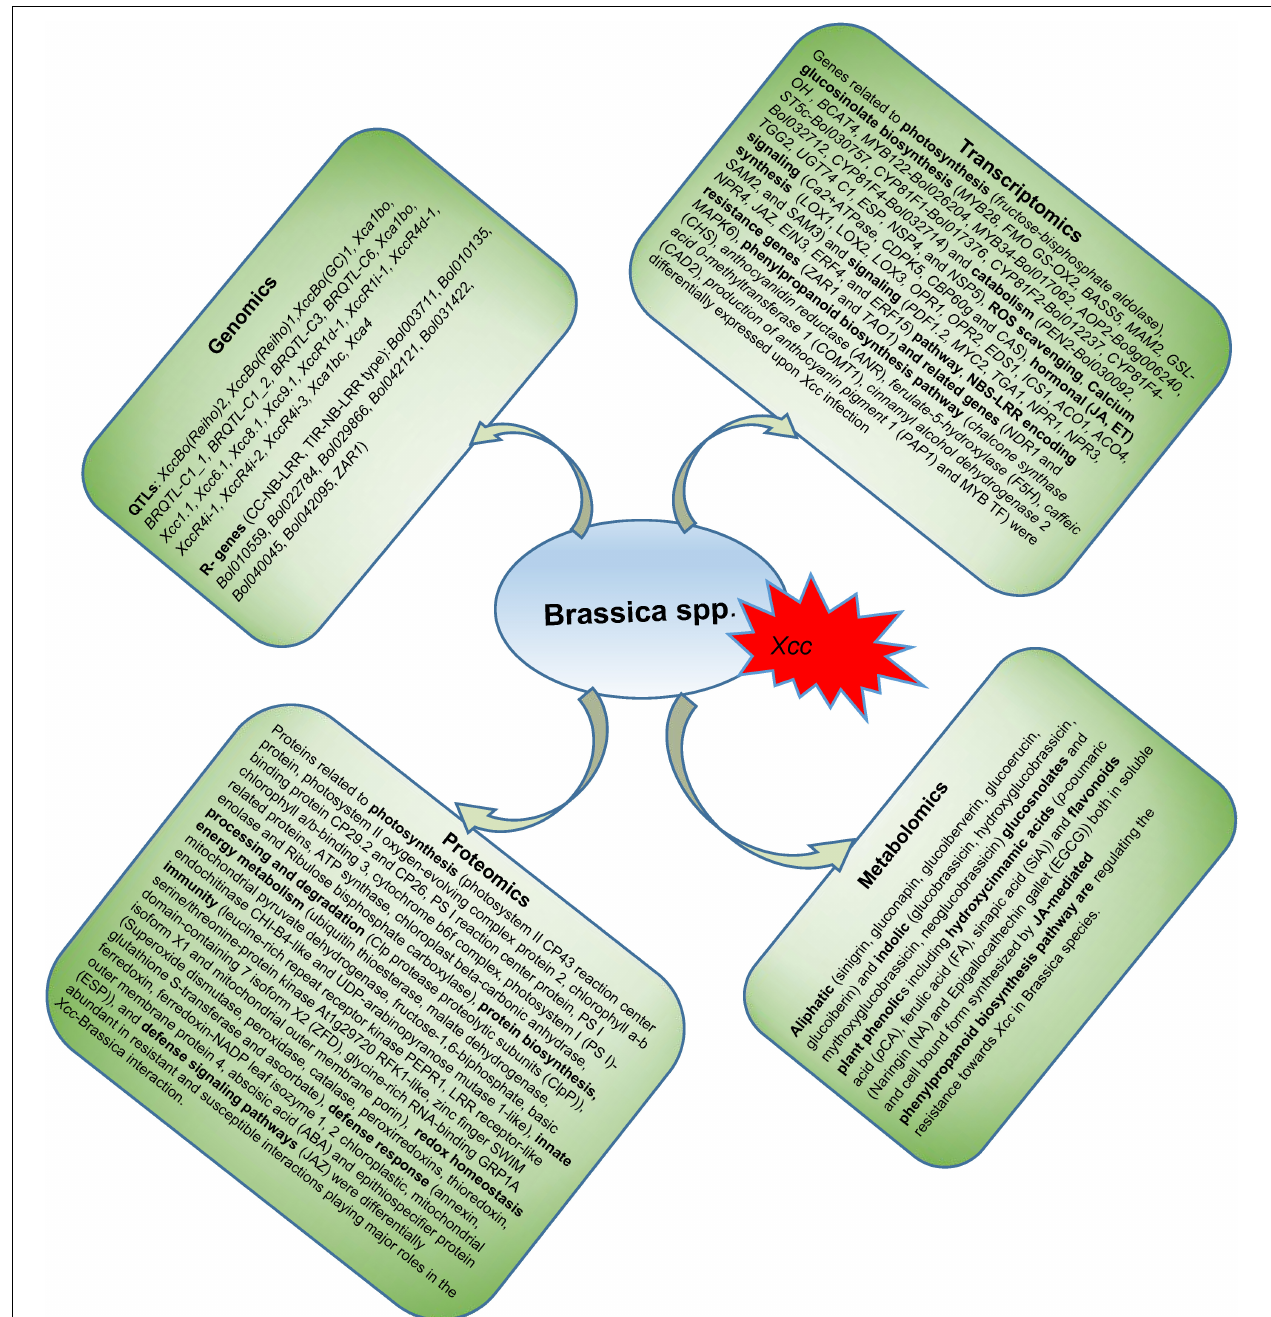
FIGURE 5 | Schematic diagram representing key genes and pathways involved in Xcc resistance in Brassica